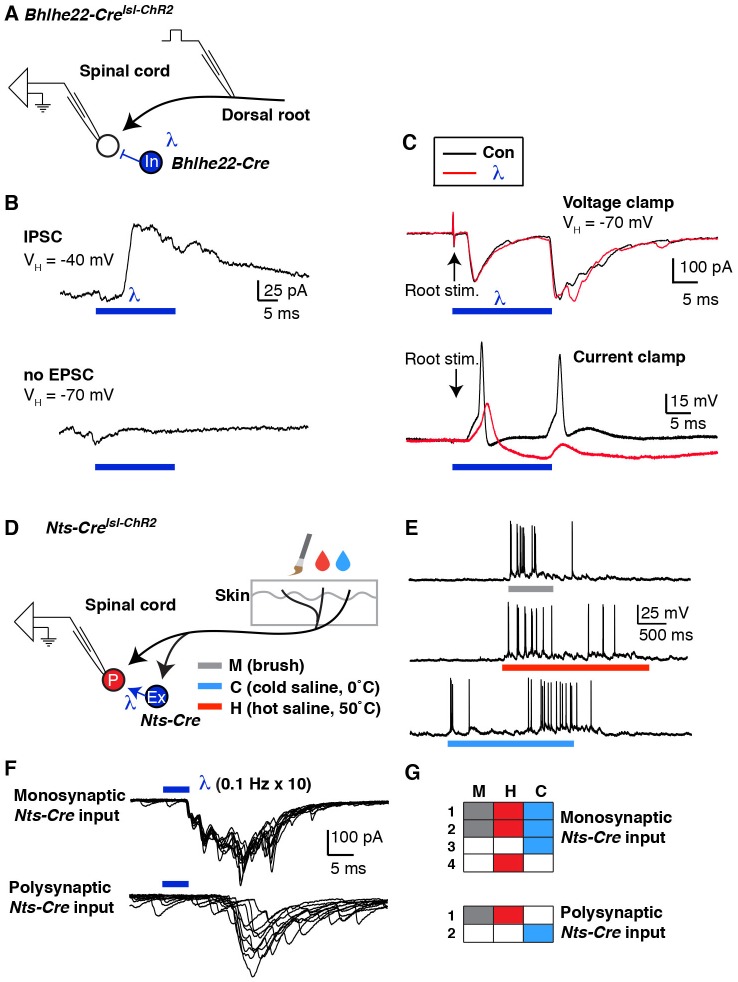
Mapping spinal connectivity using optogenetics.(A) Diagram illustrating experimental set-up to test the effect of optogentic activation of Bhlhe22-Cre neurons on action potentials mediated by dorsal root stimulation. (B) The recorded cell receives a light-evoked IPSC (top trace) but no light-evoked EPSC (bottom trace). (C) EPSCs (top) and action potentials (bottom) upon electrical stimulation of the dorsal root (arrows) in the absence (black trace) and presence (red trace) of blue light. (D) Diagram illustrating experimental set-up to characterize the modality tuning of spinal projection neurons and characterize whether they receive input from Nts-Cre interneurons. (E) Example of a lamina I projection neuron that responds to mechanical stimulation, heat and cold. (F) Representative traces of lamina I spinal projections that receive direct monosynaptic input from Nts-Cre cells (top) or only polysynaptic Nts-Cre cells (bottom). Ten traces are superimposed to compare response jitter. (G) Modality tuning characteristics of 4 spinal projection neurons that receive monosynaptic Nts-Cre input (top) and two spinal projection neurons that receive only polysynaptic Nts-Cre input (bottom).